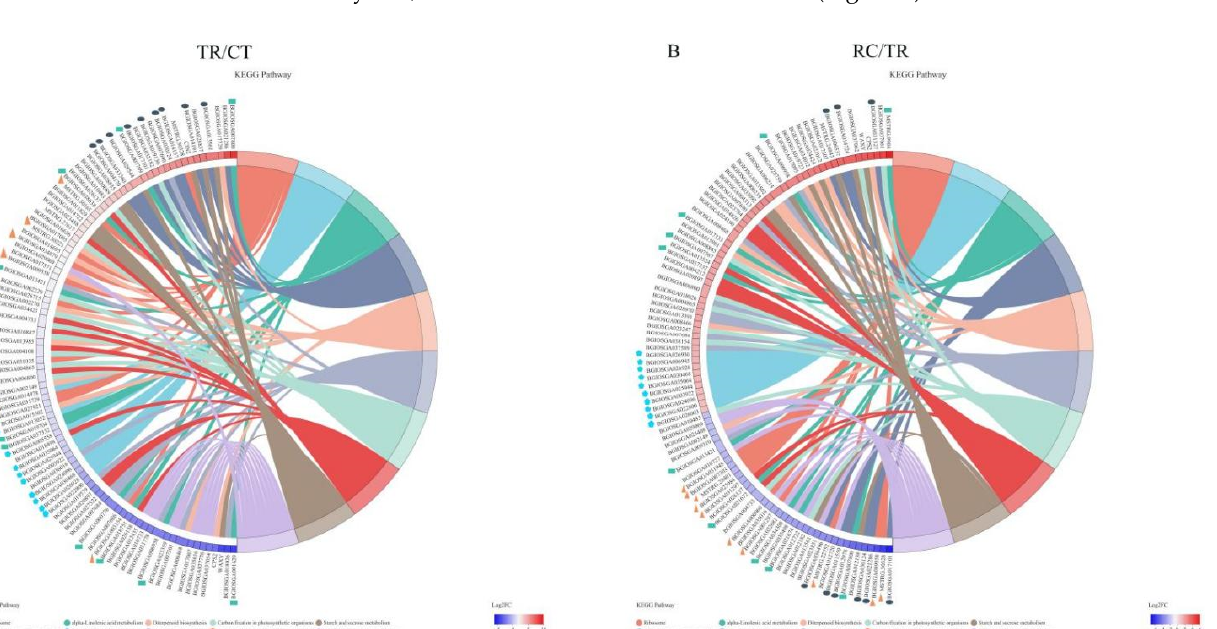
Figure 6. Functional characterization of chilling and recovery-responsive genes under chilling and/or subsequent recovery. CT: Normal-temperature treatment. TR: Chilling treatment. RC: Re- covery to normal-temperature treatment. TR/CT: From normal temperature to chilling. RC/TR: From chilling recovery to normal temperature. The red columns show the differential expressed genes under RC/TR. The black columns show differential expressed genes under TR/CT.